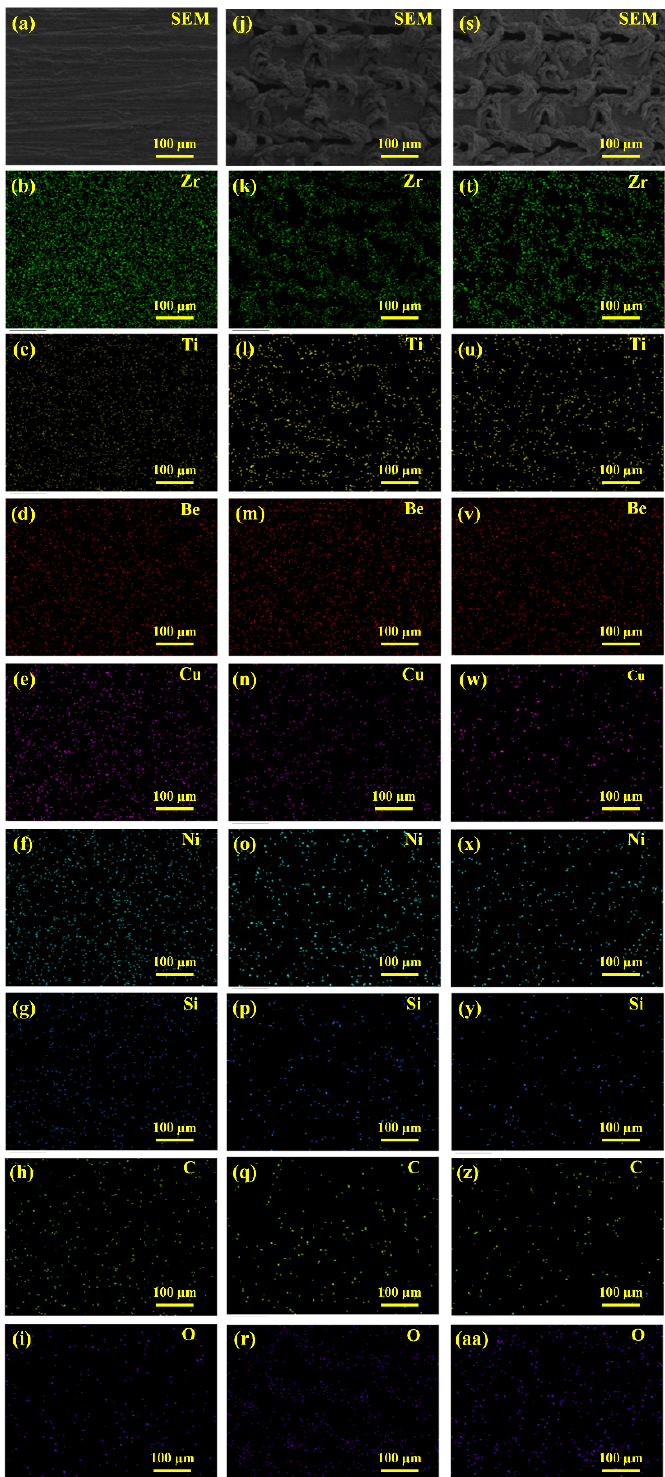
Figure 8. SEM/EDAX element mapping for ( a – i ) untreated BMG surface; ( j – r ) laser textured BMG surface; ( s – aa ) laser textured BMG surface followed by heat treatment. ( a , j , s ) are SEM micrographs representing the corresponding analyzed regions; ( b – i , k – r , t – aa ) are the EDAX maps showing the qualitative elemental distributions of Zr, Ti, Be, Cu, Ni, Si, C, and